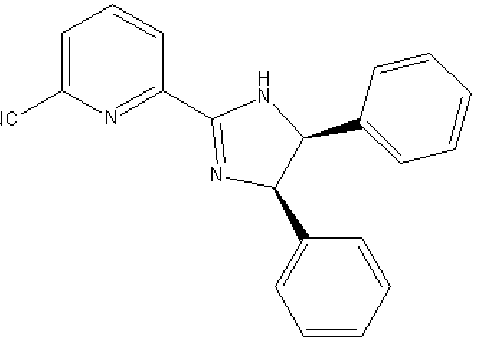
Figure 1. Structure of ( R,S